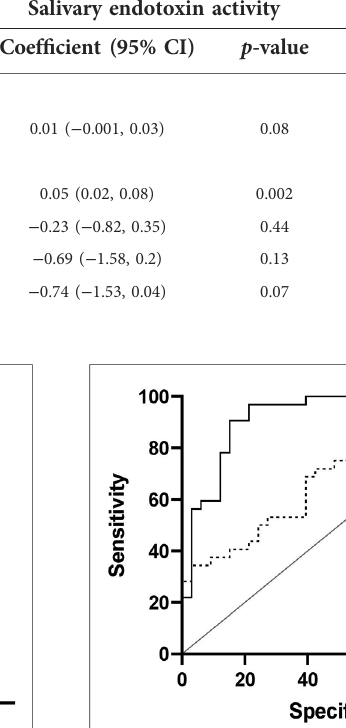
TABLE 4 Multivariate analyses of correlations between salivary endotoxin activity levels, clinical and demographic characteristics of the patient cohort, adjusted for age, gender and smoking status.